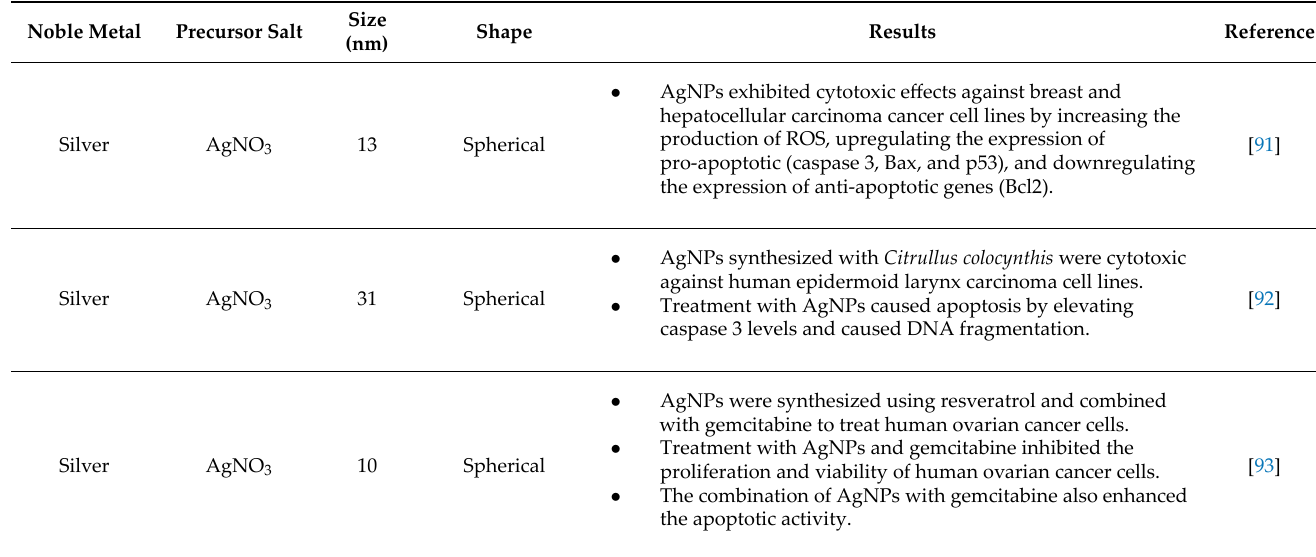
Table 1. Applications of noble metal-based nanoparticles against different types of cancer. Noble Metal Precursor Salt